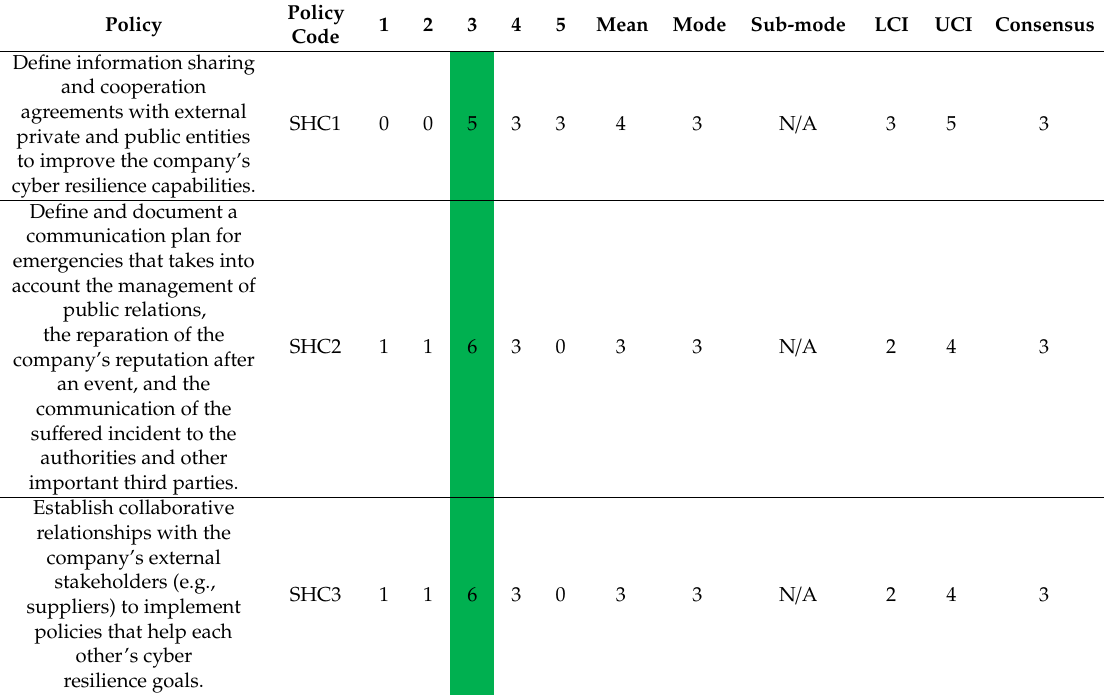
Table 29. Information sharing and communication starting